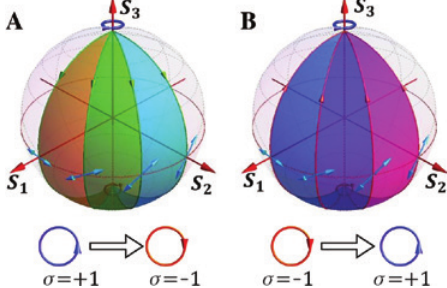
Figure 10: The accumulations of PB phase for the opposite spin components, the left picture (A) shows the transformation from left circular polarization ( σ = + 1) to right one ( σ = - 1). Oppositely, the right picture (B) shows the transformation in a different direction. As the reversal of incident polarization, the sense of generated PB phase will be